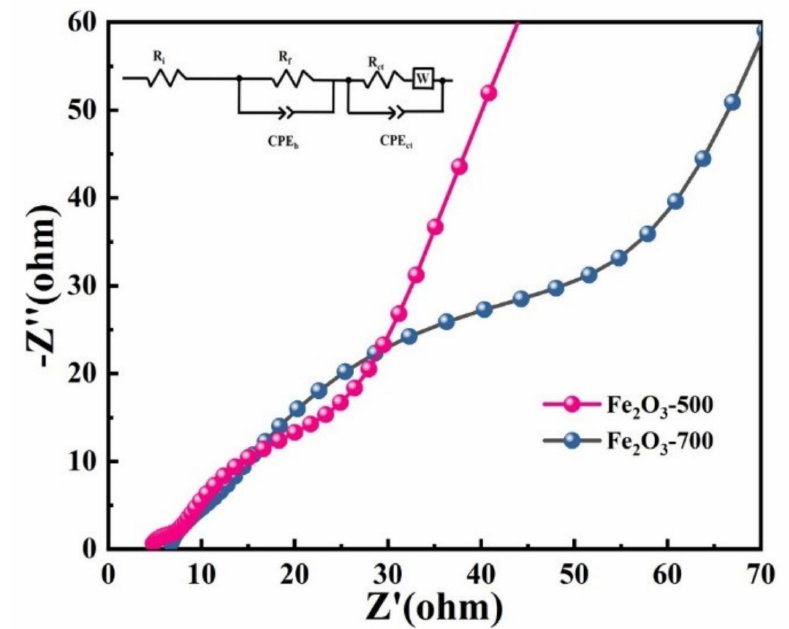
Figure 5. Nyquist plots of Fe 2 O 3 -500 and Fe 2 O 3 -700 electrodes after 50